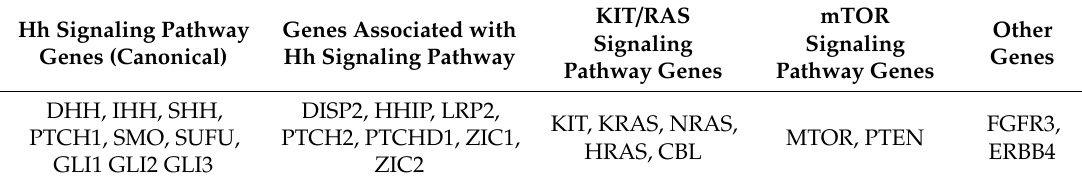
Table 1. Custom-designed NGS-based gene